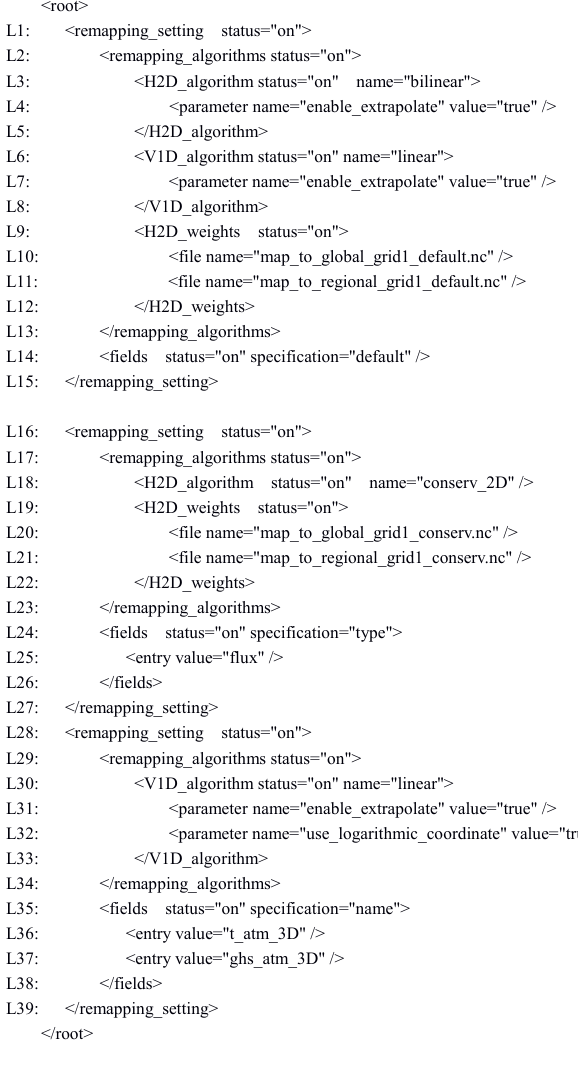
Figure 6. Sample of a remapping configuration Figure 6 Sample of a remapping configuration file